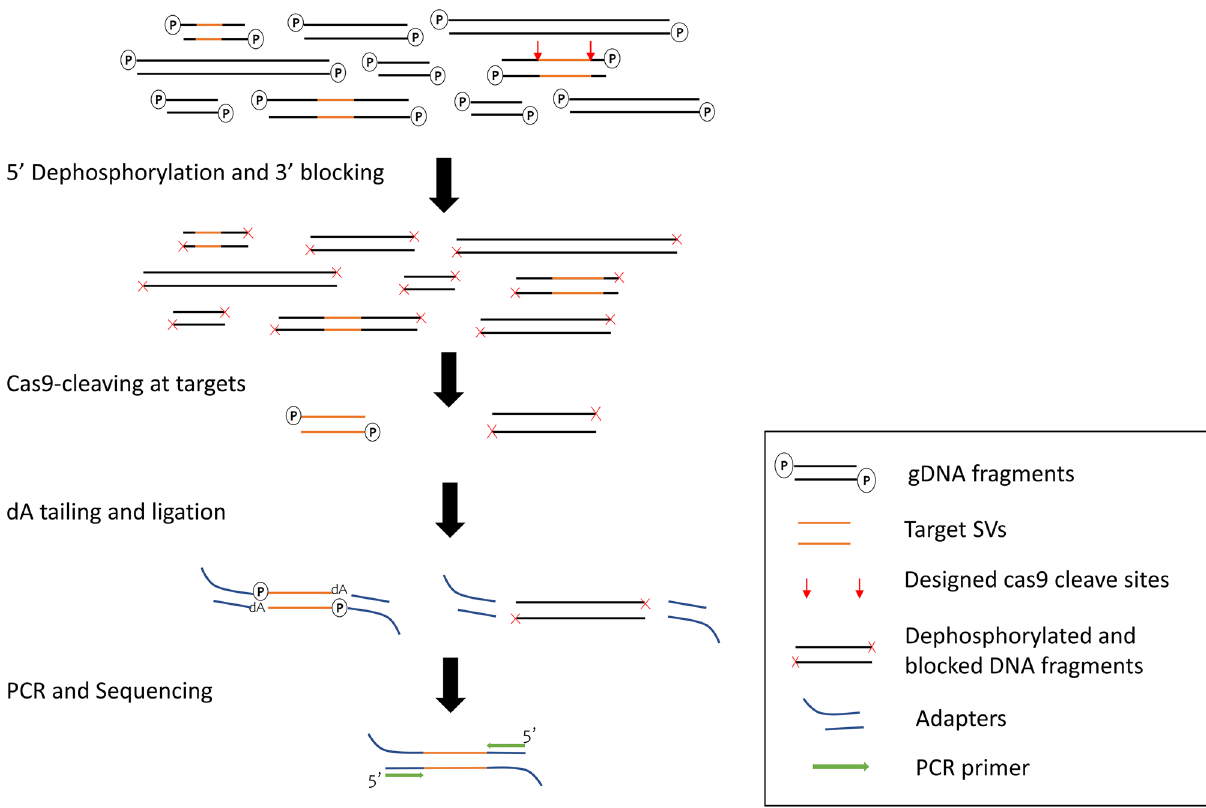
Figure 1. Schematic showing cas9-assisted targeted nanopore sequencing workflow. Genomic DNA was blocked at 5 ′ and 3 ′ ends to discourage non-specific ligation. The target loci were cut at the designed cleave sites there by exposing fresh DNA ends amenable to a universal adapter ligation. Following this, all loci were PCR amplified. Purified amplicons were sequenced on a nanopore